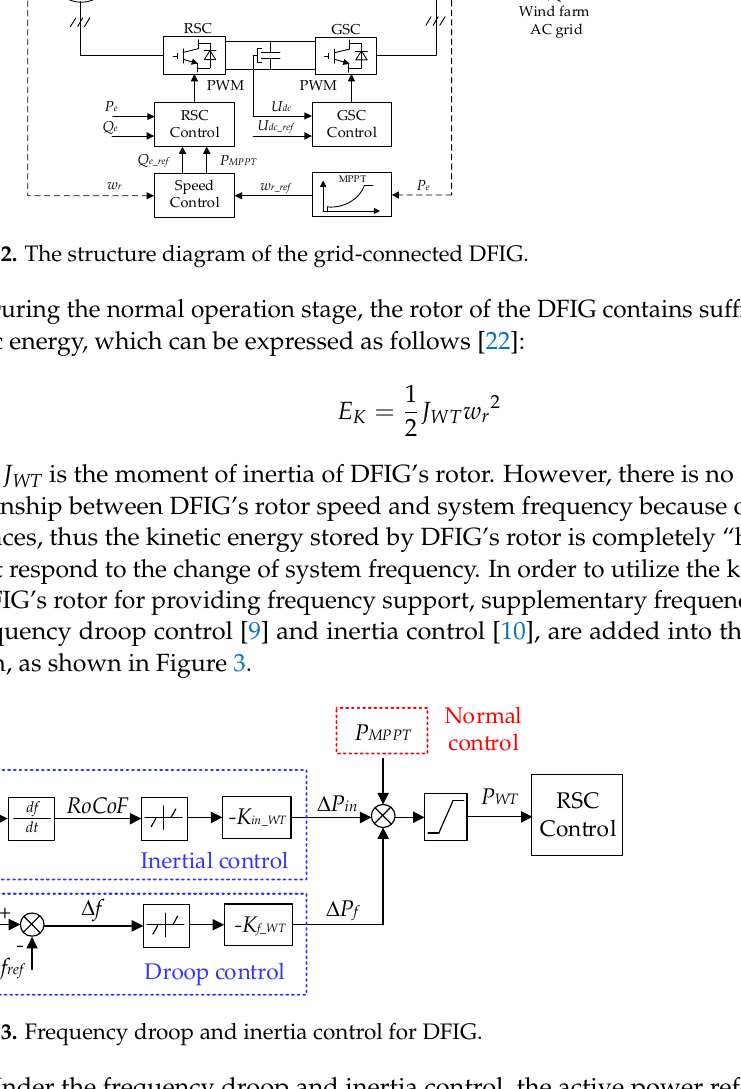
Figure 2. The structure diagram of the grid-connected DFIG.